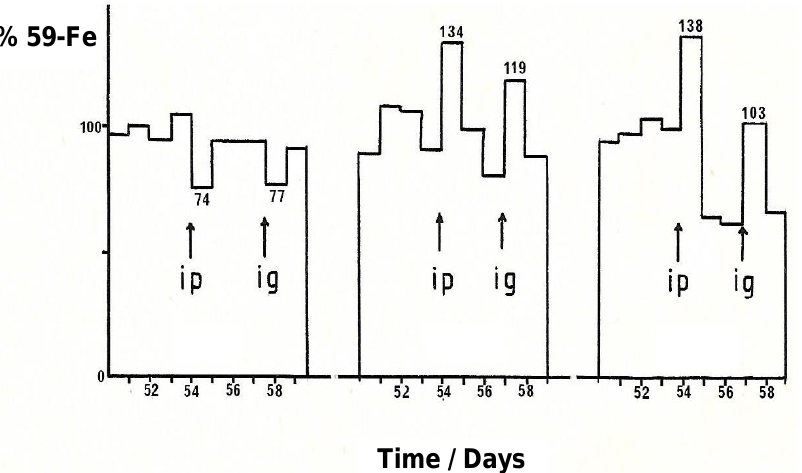
Figure 7. The effect of maltol on daily iron excretion in mice. The profile of iron (59-Fe) excretion in iron loaded, 59-Fe labelled mice following treatment with maltol (250–300 mg/kg). Maltol was administered in three mice initially intraperitoneally (ip) and after 3 days intragastrically (ig), as indicated by arrows. In each mouse, the mean iron (59-Fe) excretion 3–4 days prior to the recorded values was considered as the background (100%) excretion of (59-Fe) [25].